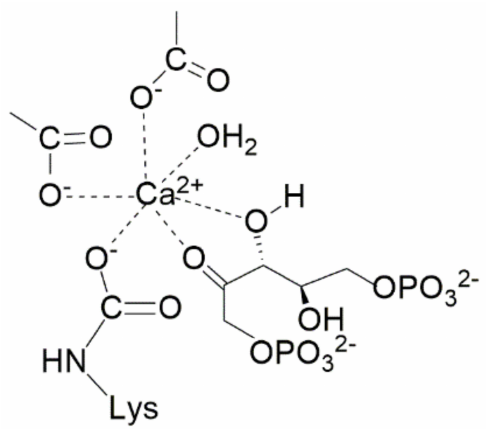
Figure 9. Structure of the active site of activated RuBP-bound Rubisco plotted from the 1RXO PDB file (Protein Data Bank) showing the coordination environment of Ca 2+ . (Figure 9 from ref. [33], adapted and used by permission of Elsevier (copyright ©